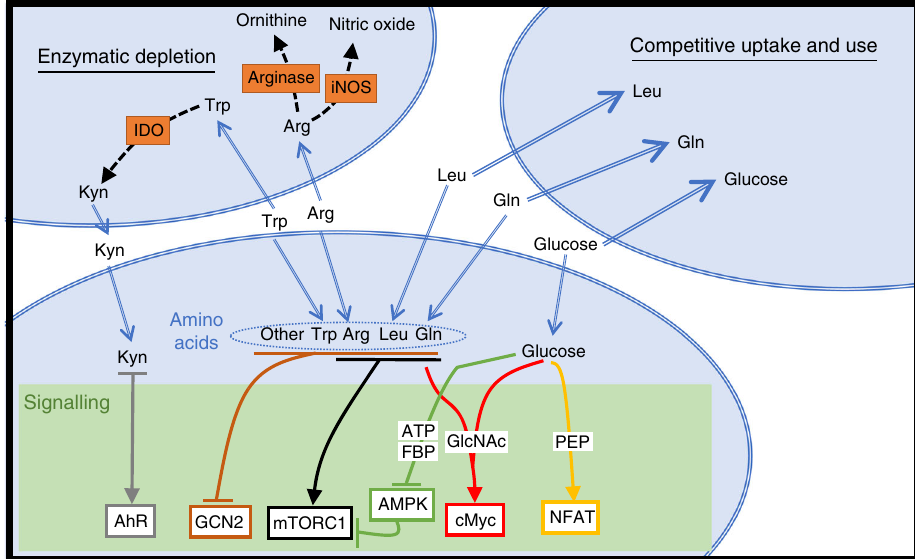
Fig. 4 Competition for nutrients and the impact on signal transduction. Decreased levels of various nutrients within immune microenvironments could occur due to competitive uptake by surrounding cells. Alternatively, the expression of enzymes that consume nutrients, such as arginase, inducible nitric oxide synthase (iNOS) and Indoleamine-pyrrole 2,3-dioxygenase (IDO), can lead to reduced levels of arginine (Arg) and tryptophan (Trp). Limiting levels of nutrients will affect various signalling pathways. Mammalian target of rapamycin complex 1 (mTORC1) signalling is sensitive to levels of arginine, leucine (Leu) and glutamine (Gln). Glucose deprivation will also activate AMP-activated protein kinase (AMPK) due to reduced levels of ATP or fructose-1,6- bisphosphate (FBP) leading to the inhibition of mTORC1 activity. The metabolite phosphoenolpyruvate (PEP), generated when glucose is metabolised by glycolysis, can affect the duration of NFAT signalling. Gln and glucose are required for the production of uridine diphosphate N -acetylglucosamine (GlcNAc) that is important in sustaining the expression of the transcription factor cMyc. Decreased levels of amino acids in general will lead to the activation of general control nonderepressible 2 (GCN2). The product of IDO-mediated Trp metabolism, kynurenine (Kyn), can promote signalling through the aryl hydrocarbon receptor (AhR). NFAT nuclear factor of activated T